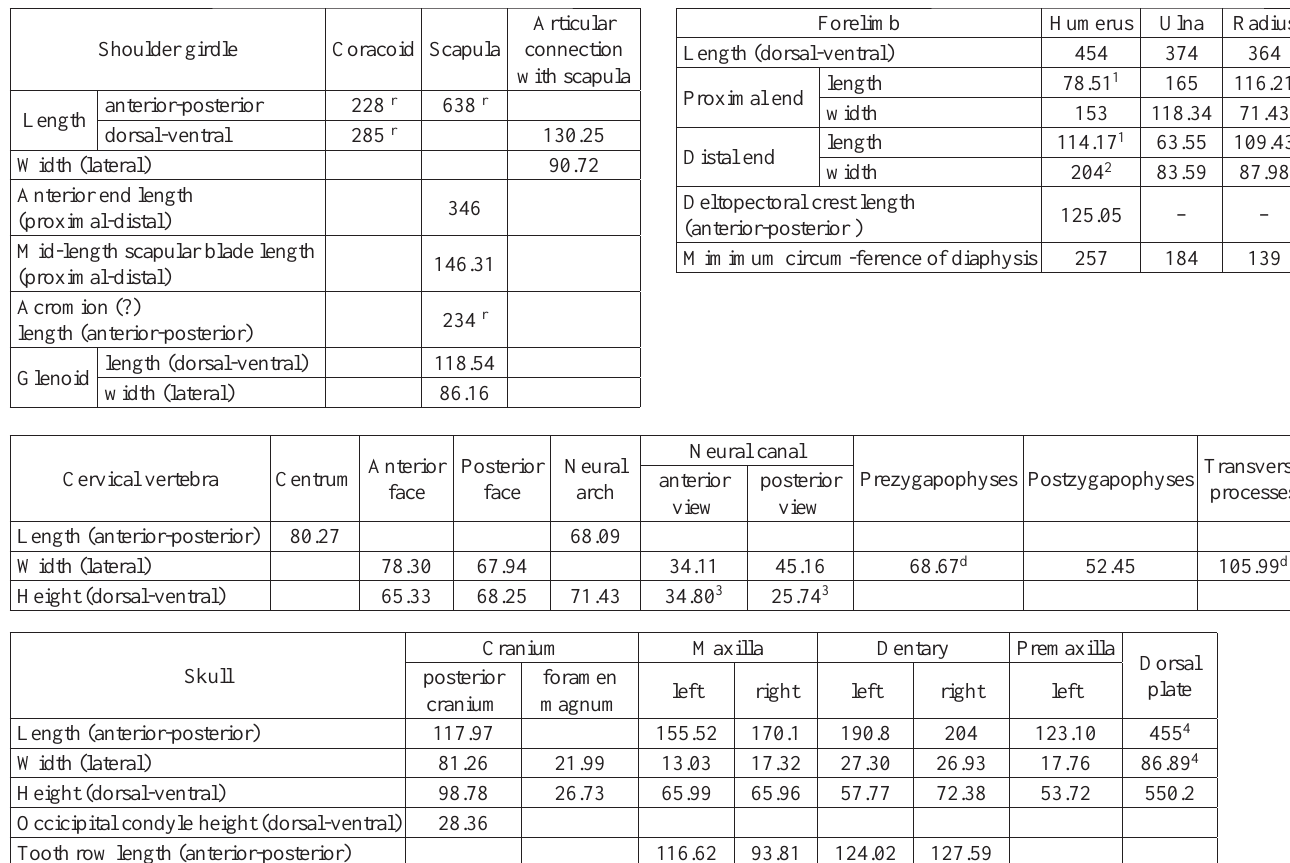
Table 2. Greatest measurements (in mm) for GPDM 178. 1 anterior-posterior length; 2 lateral width; 3 anterior-posterior height; 4 length of ventral margin; d, damaged; r,